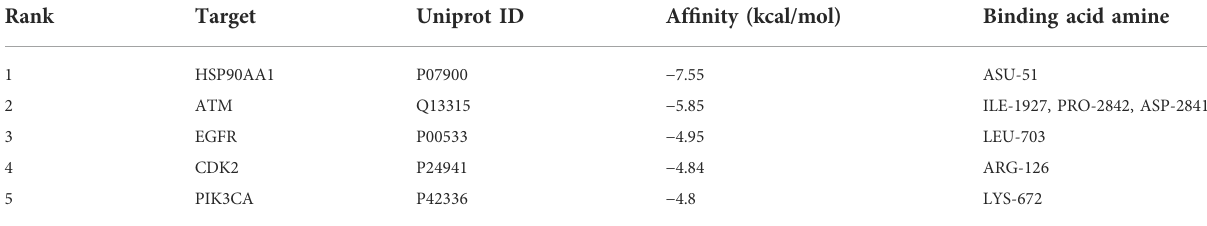
TABLE 4 Different binding energies and binding acid amine of SchB polysul fi des with fi ve selected targets. Rank